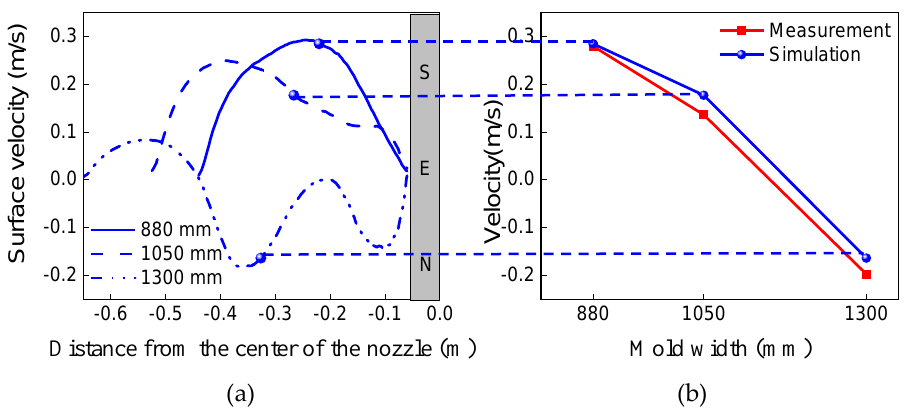
Figure 3. Flow velocities near the mold surface with different mold widths under the low steel throughput ( a ) distribution in the width direction and ( b ) comparison between measured and calculated values.